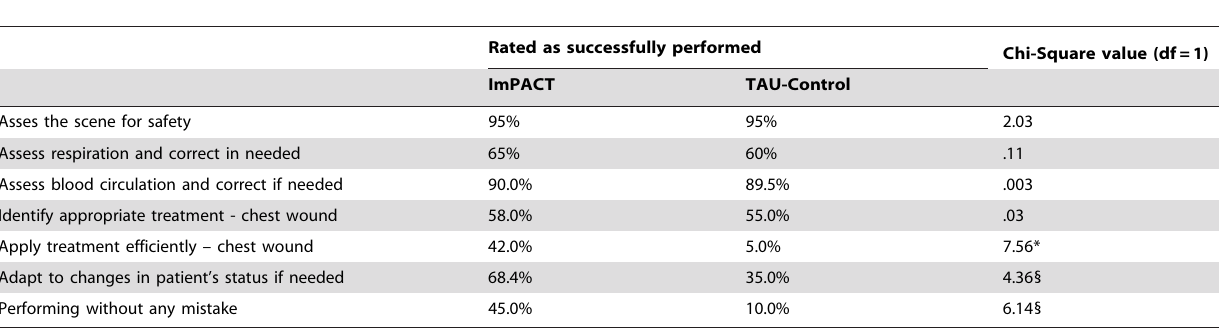
Table 3. Trainees Evaluation Sheet rated by ‘‘blind’’ military medical instructors during the simulation describing the percentage of participants who followed adequately the official first aid protocol.